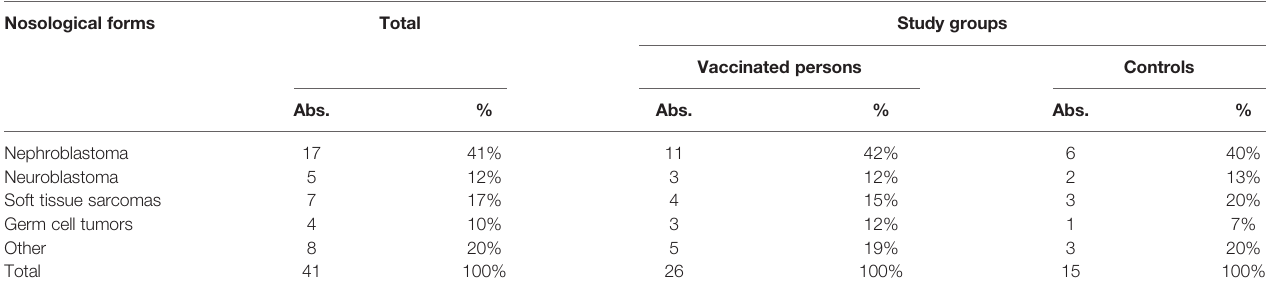
TABLE 1 | Nosological forms of diseases in revaccinated children (n = 26) and controls without revaccination (n = 15). Nosological forms